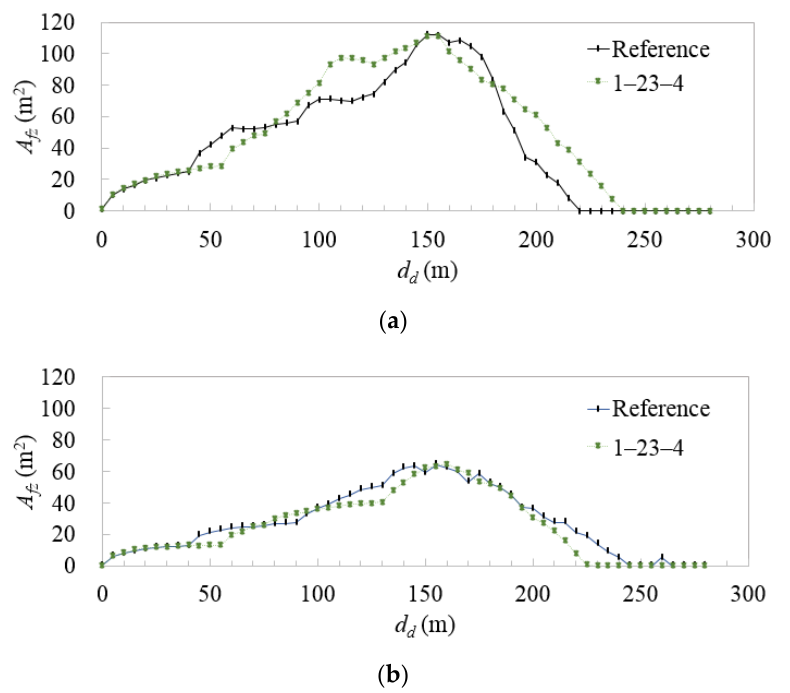
Figure 8. Area of FZ ( V fz ) at every 5 m cross section for the arrangement of 1 ‒ 23 ‒ 4 and reference based on the drifting distance (d d ) from the first vent mast: at a relative wind speed of ( a ) 10 m/s, and ( b ) 20 m/s.